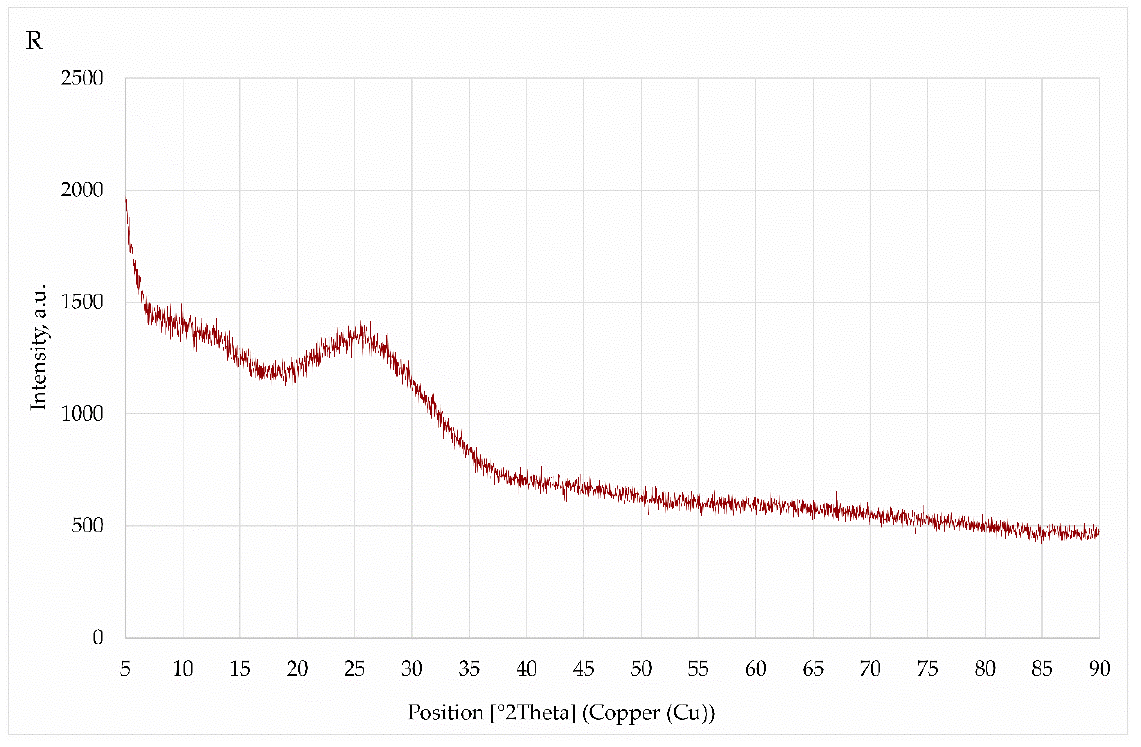
Figure 4. Diffractogram for ultra-fine fly ash R.